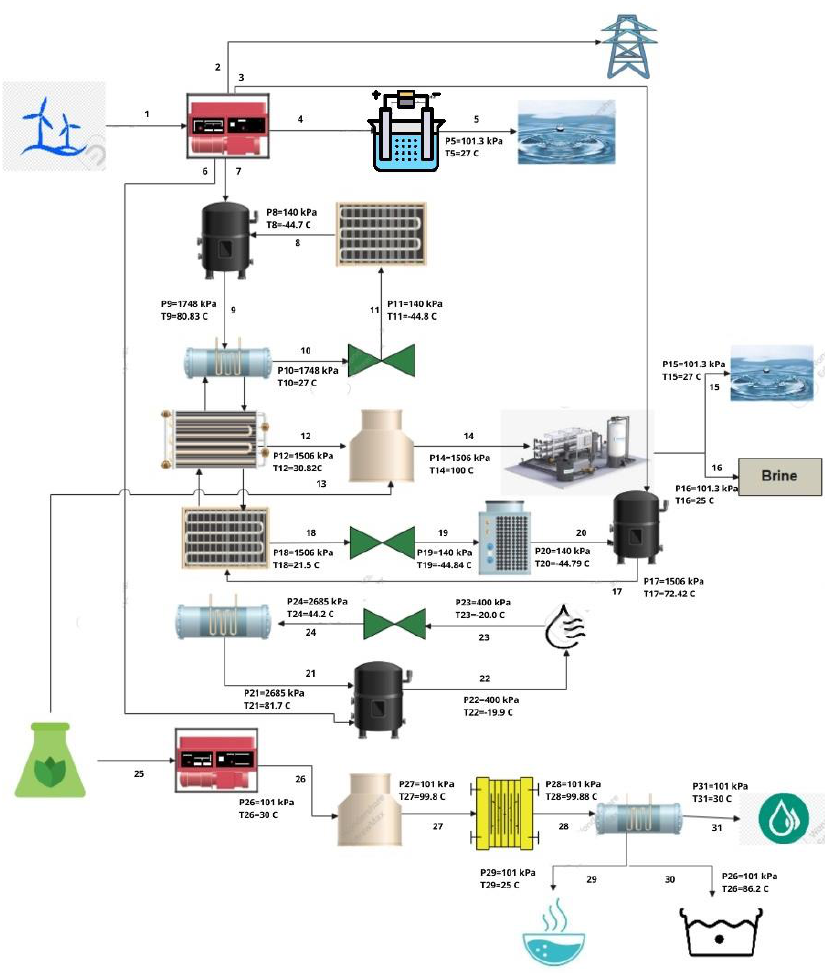
Figure 1. Schematic diagram.